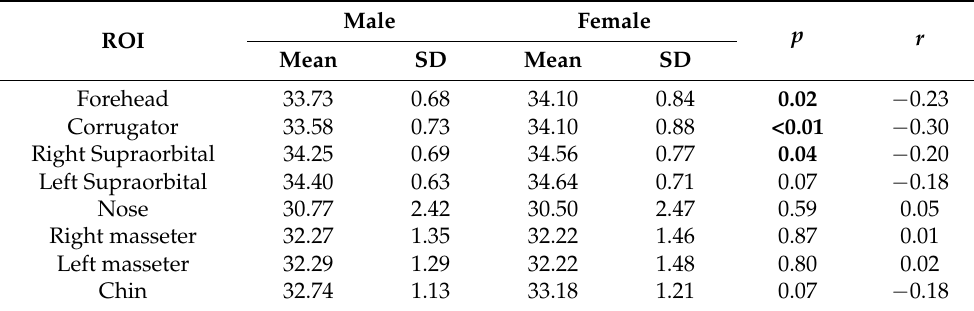
Table 3. Gender comparison table.